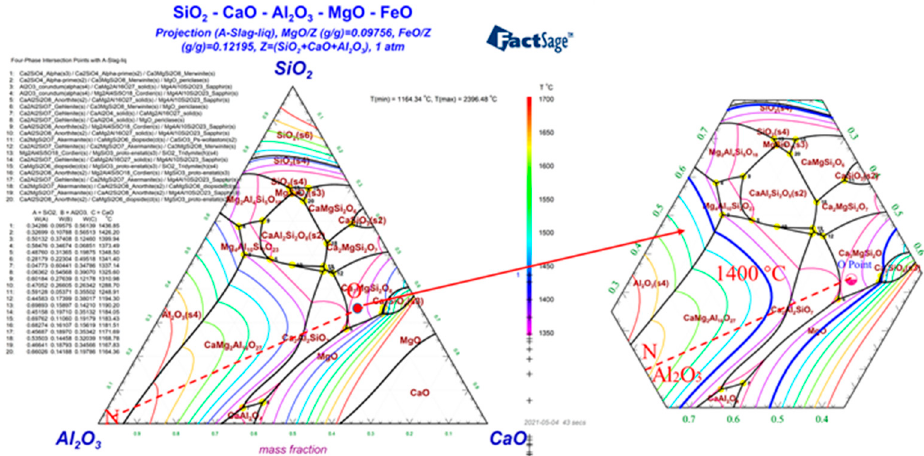
Figure 10. CaO-SiO 2 -Al 2 O 3 -8% MgO-10% FeO quinary phase diagram.